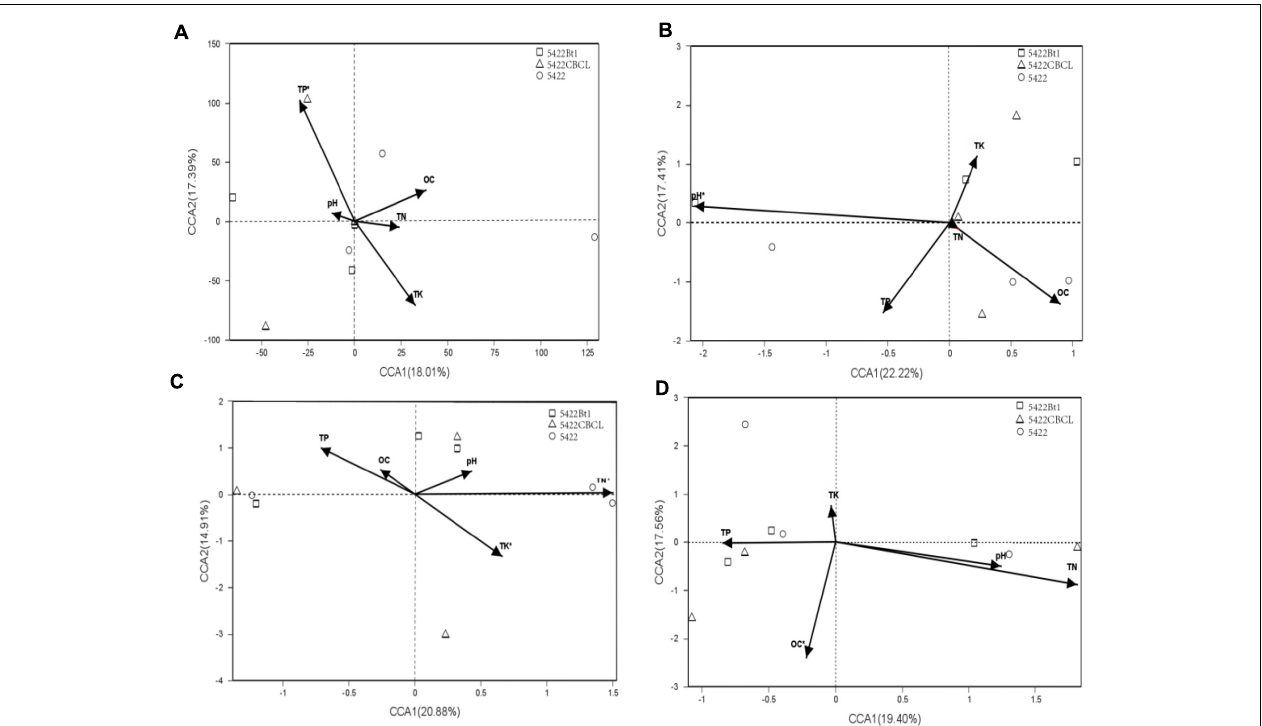
FIGURE 4 | Canonical correspondence analyses (CCA) biplot showing the relationship between the detected varieties and soil characteristics in samples. (A) Roots of maize varieties cultivated at the 5 th season. The related eigenvalues were as follows: DCA1 = 1.1976, DCA2 = 15.8373, DCA3 = 2.9401, DCA4 = 7.0103. pH:P = 0.902, OC: P = 0.506 , TN: P = 0.768 , TP: P = 0.001 , TK: P = 0.096. (B) Rhizosphere soils of maize varieties cultivated at the 5 th season. The related eigenvalues were as follows: DCA1 = 4.8569, DCA2 = 3.264, DCA3 = 1.83, DCA4 = 1.83, pH:P = 0.003 , OC: P = 0.12 ,TN: P = 0.99 , TP: P = 0.179 , TK: P =